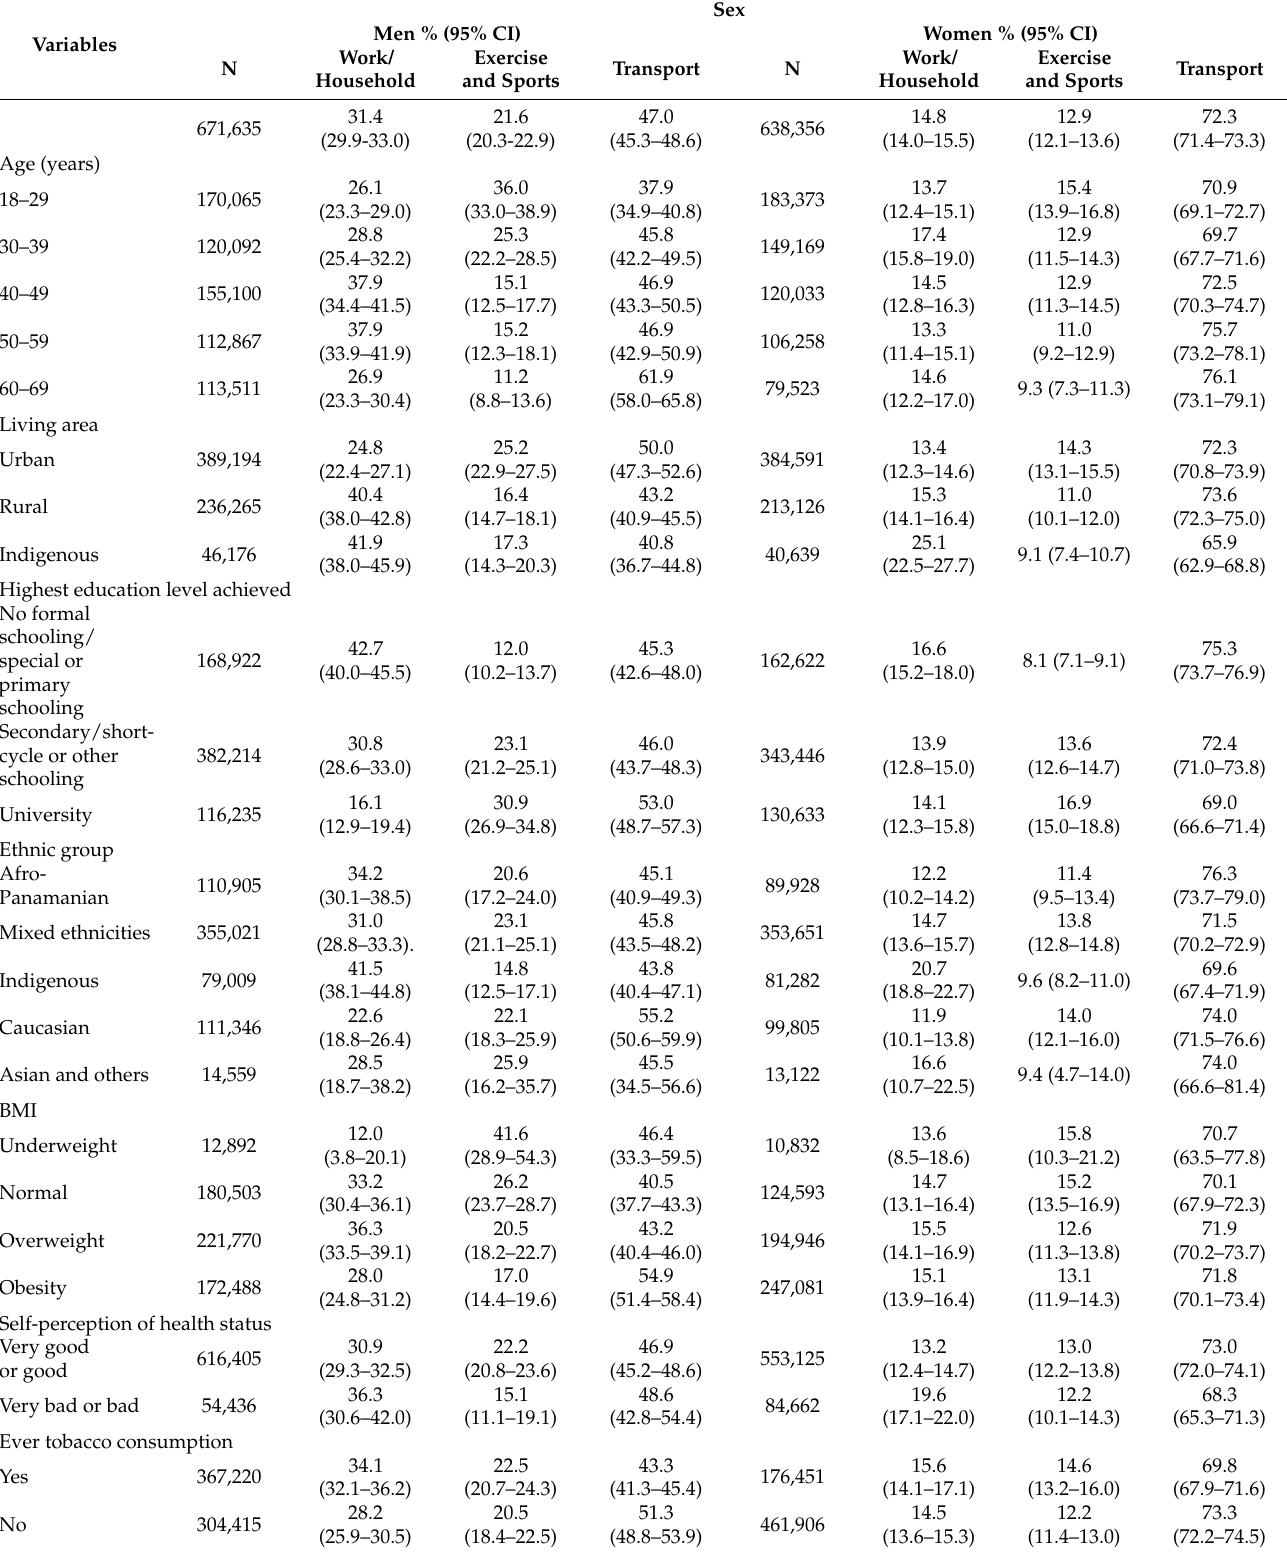
Table 4. Relative domain contribution to the total estimated energy expenditure (EEE) of physical activity (PA)/week among individuals aged 18–69 years engaging in at least 10 min of continuous PA, according to sex and the selected variables. Panama,